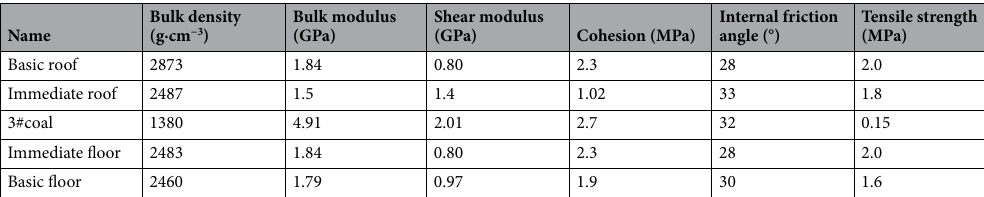
Table 1. Rock mechanics parameter.